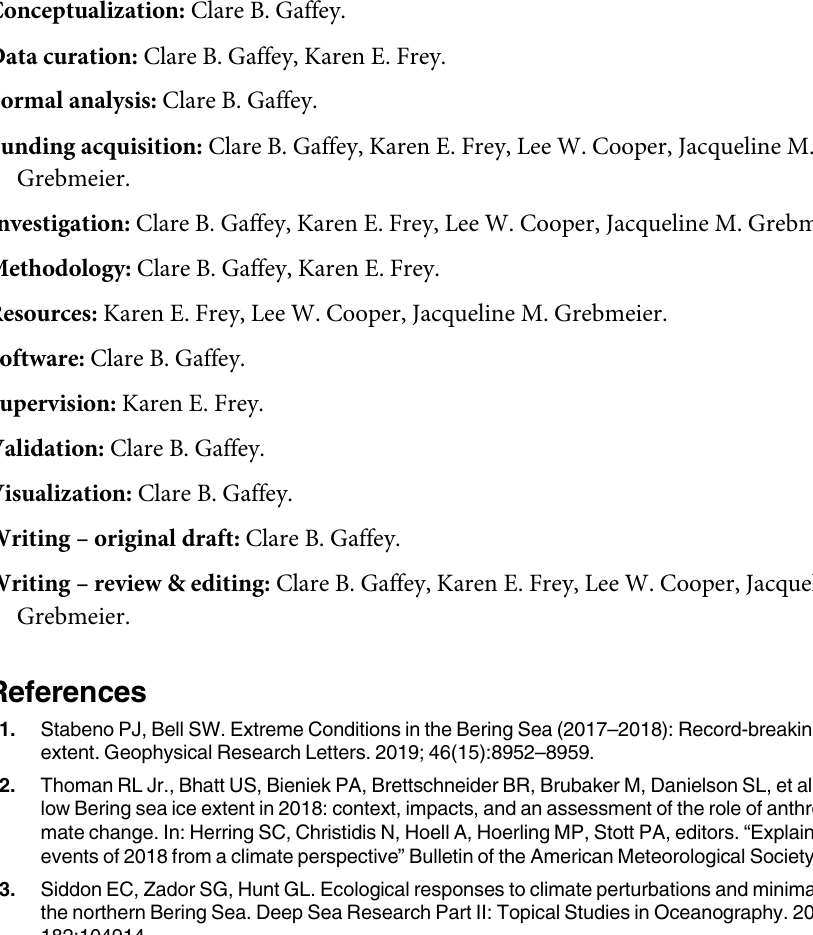
S3 Table. Sea ice breakup date changepoint analysis. The sea ice breakup dates changepoint analysis results to determine the day of year (DOY) threshold to distinguish high versus low sea ice years within our study duration per station. These were derived using the methodology described in S1 Appendix. S4 Table. Sea ice high and low years and depth-integrated pheophytin proportions. High and low sea ice years were distinguished using DOY thresholds determined per station based on sea ice breakup date (SIB) and by sea ice concentration (SIC) relative March–May coverage at each station during the 2013–2019 time